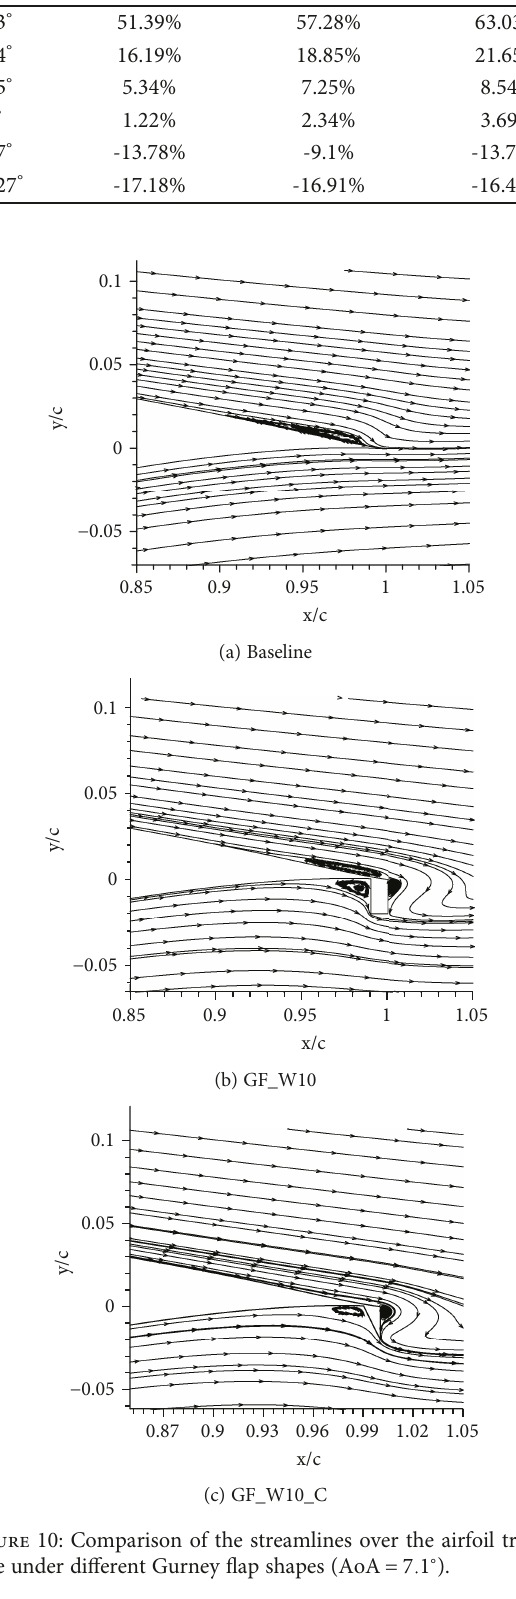
Figure 10: Comparison of the streamlines over the airfoil trailing edge under di ff erent Gurney fl ap shapes ( AoA = 7 1 °